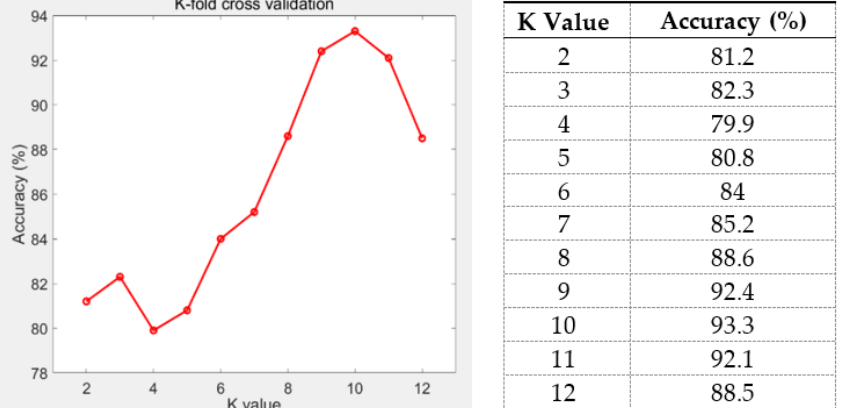
Figure 12. Results of K-fold validation for evaluating the classification performance of the algorithm. When the K value is equal to N , this algorithm performs the verification N times and calculates the average value for all the results. A K value of 10 yielded the best results. If the K value exceeds 10, the accuracy gradually decreases.